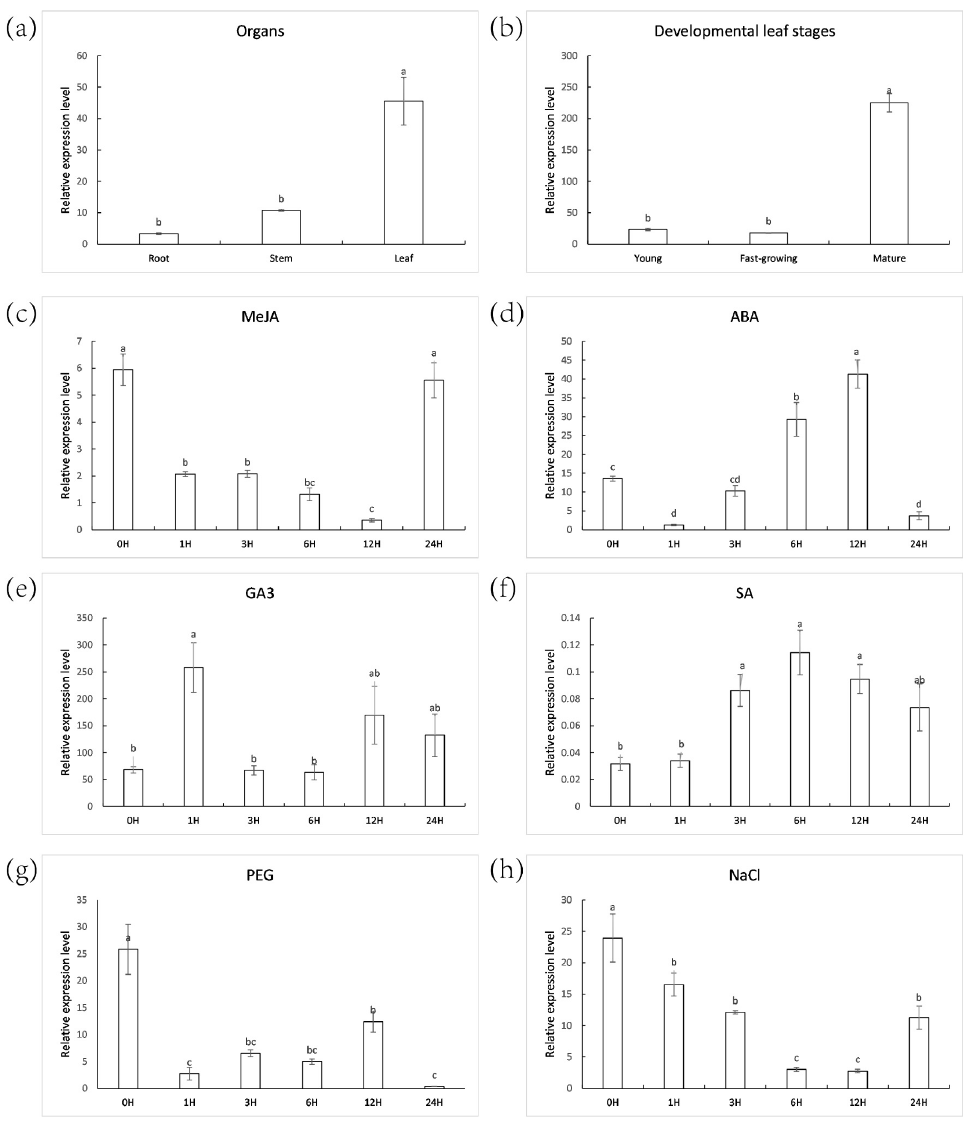
Figure 3. ZjNOL expression profiles. ( a ) Expression pattern of ZjNOL in the root, stem, and leaf. ( b ) ZjNOL expression pattern in leaves at various phases of development. ( c – f ) Leaf expression pattern after 10 mM MeJA treatment ( c ), 10 mM ABA treatment ( d ), 10 μ M GA3 treatment ( e ), 0.5 mM SA treatment ( f ). ( g , h ) Leaf expression analysis of ZjNOL after 20% PEG4000 ( g ), 300 mM NaCl ( h ). Significant differences ( p < 0.05, n = 3) are shown by different letters above the columns.